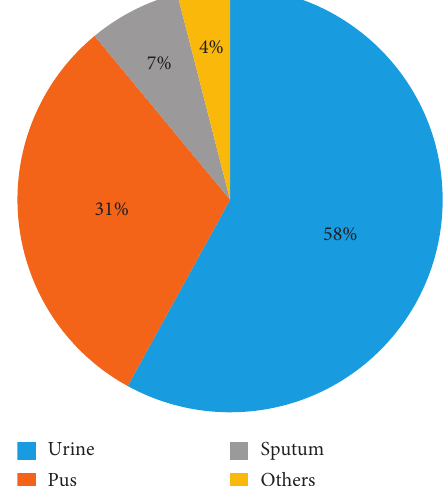
Figure 1: Isolates investigated in this study were obtained from sample groups ( ∗ Others, 2 from blood culture and 1 each from cere- brospinal fluid and high vaginal swab). The collected Enterobacteriaceae consisted of E . coli (51%), Klebsiella spp. (19%), Proteus group (19%), Serratia spp. (7%), and Enterobacter spp. (4%).